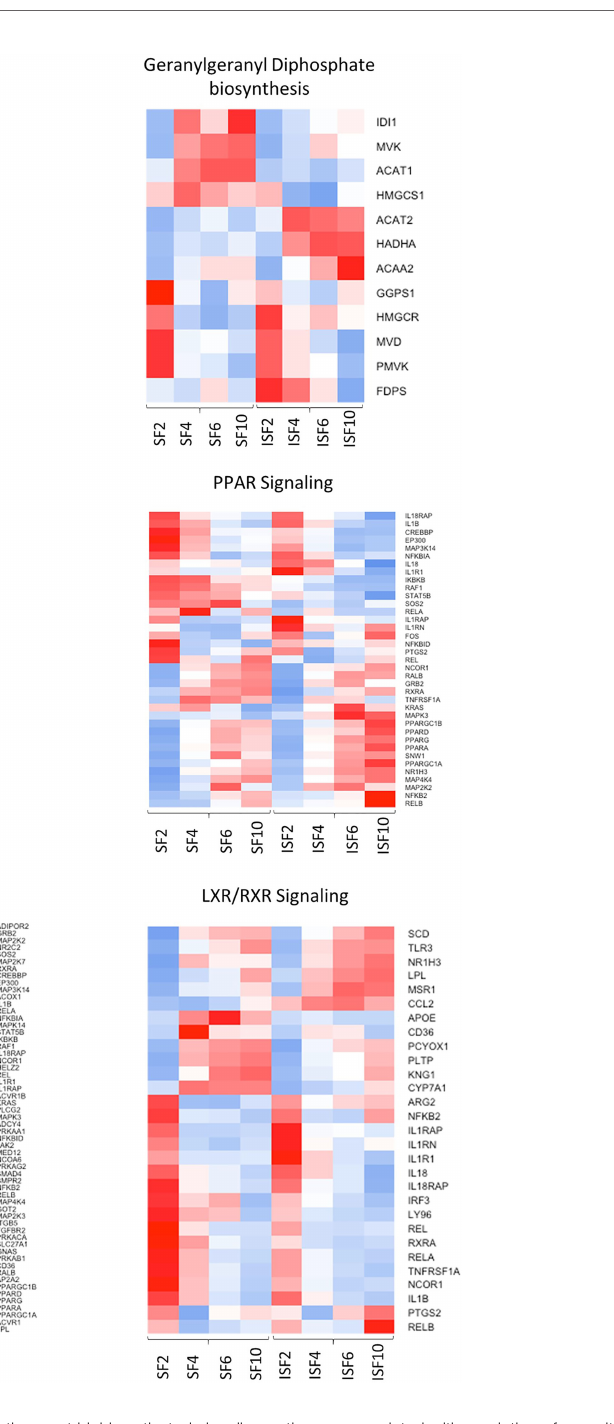
FIGURE 6 | Heatmaps depicting the patterns of expression of genes involved in the most highly activated signaling pathways associated with resolution of synovitis, comparing BMNC cultured in SF and ISF. Further details are available at Supplementary Table 4